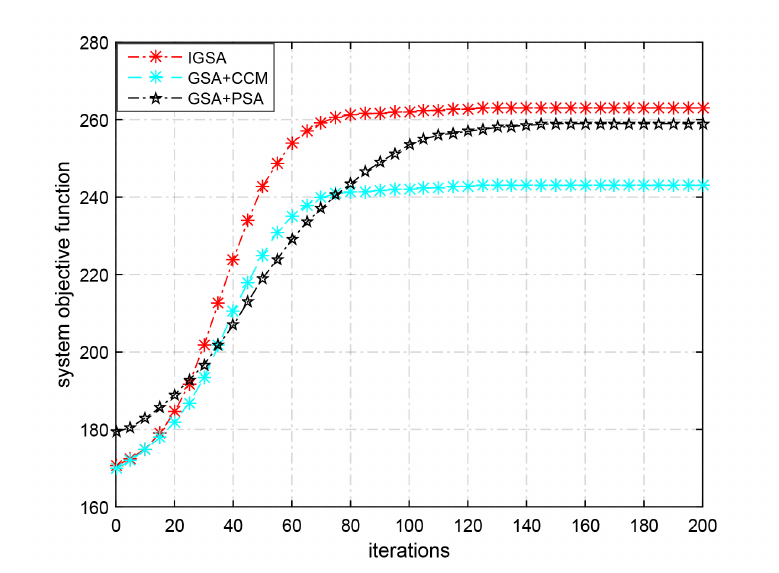
Figure 2. Performance of the GSA-based improved